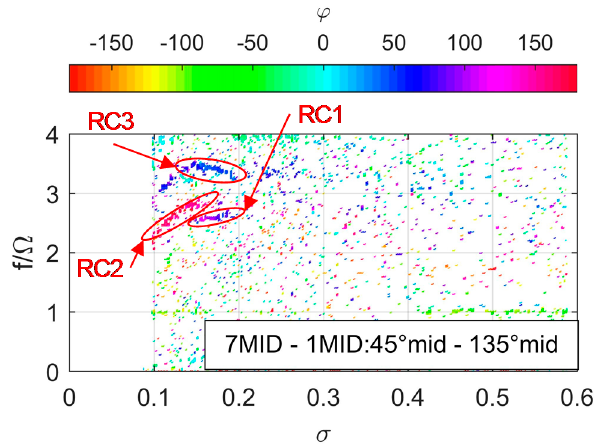
Figure 11. Cross-spectrum phase ( ϕ ) of the midstream pressure transducers, Φ = 0.108 (90% Φ D ). circled phenomena are summarized in Table 8. Int. J. Turbomach. Propuls. Power 2018 , 3 , x FOR PEER REVIEW